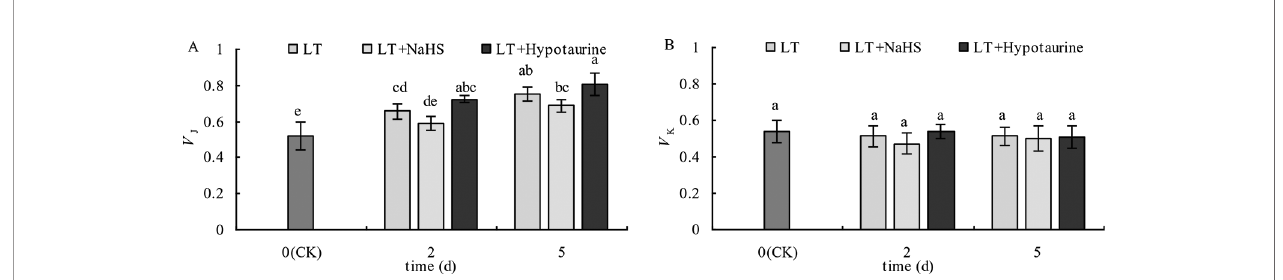
FIGURE 5 | Effects of exogenous NaHS and Hypotaurine on V J (A) and V K (B) of blueberry leaves under low temperature stress. The data in the fi gure are from fi ve replicated experiments (n = 5), and represent means ± standard error (SE). Different small letters show signi fi cant differences ( P < 0.05). CK: room temperature control at 25°C; LT: low temperature treatment; LT + NaHS: low temperature treatment at 4 – 6°C after spraying 0.5 mmol·L – 1 NaHS; LT + Hypotaurine: low temperature treatment at 4 – 6°C after spraying leaves with 200 m mol·L – 1 hypotaurine.